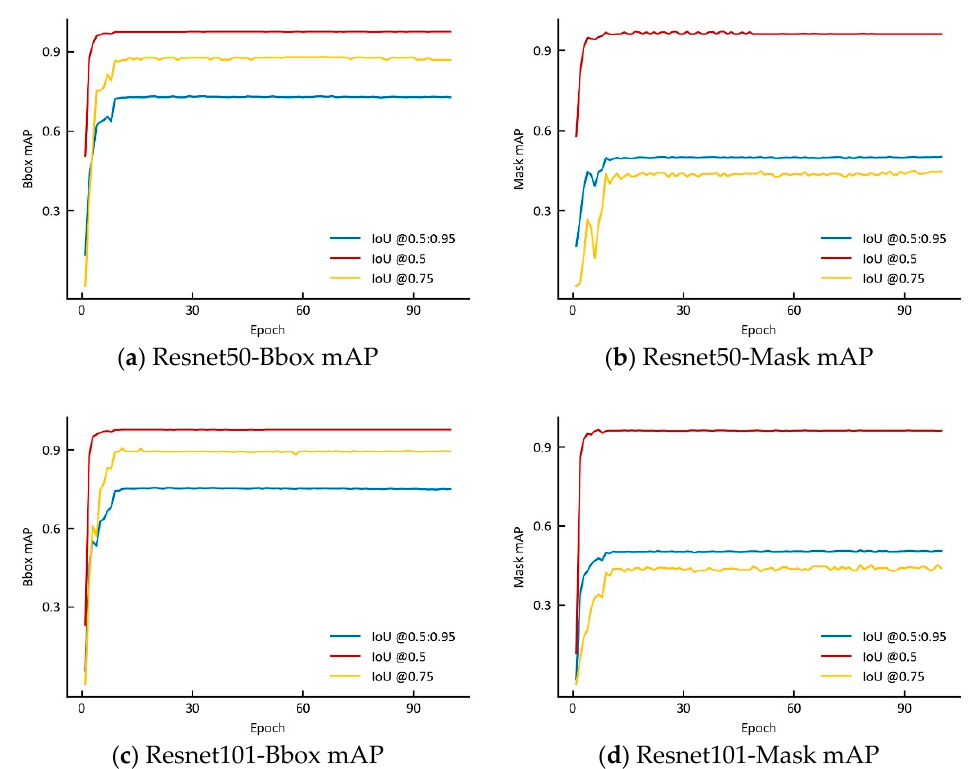
Figure 5. Performance of Mask R-CNN model with Resnet50 and Resnet101 as backbone networks on different IoUs (Intersections over Union) when the loss function is SmoothLR. Table 2. Performance of Mask R-CNN model with different backbone networks and loss functions on the test set.